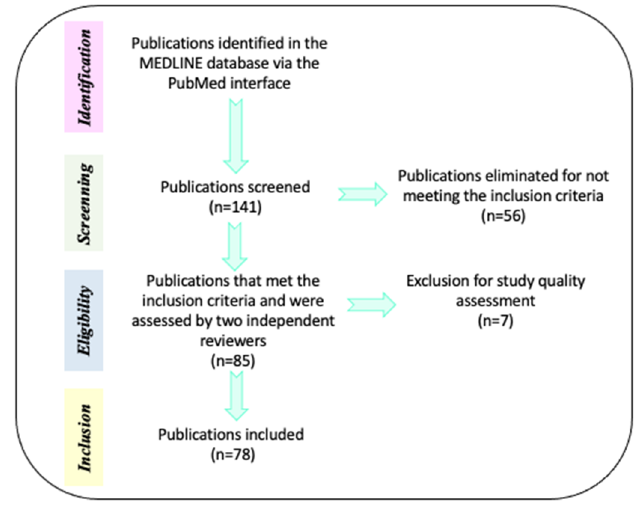
Figure 1. Methodological process for references selection. Description of the steps performed for the search and selection of references used for this review. Table 2. A summary of the main findings of each reference examined for this review.